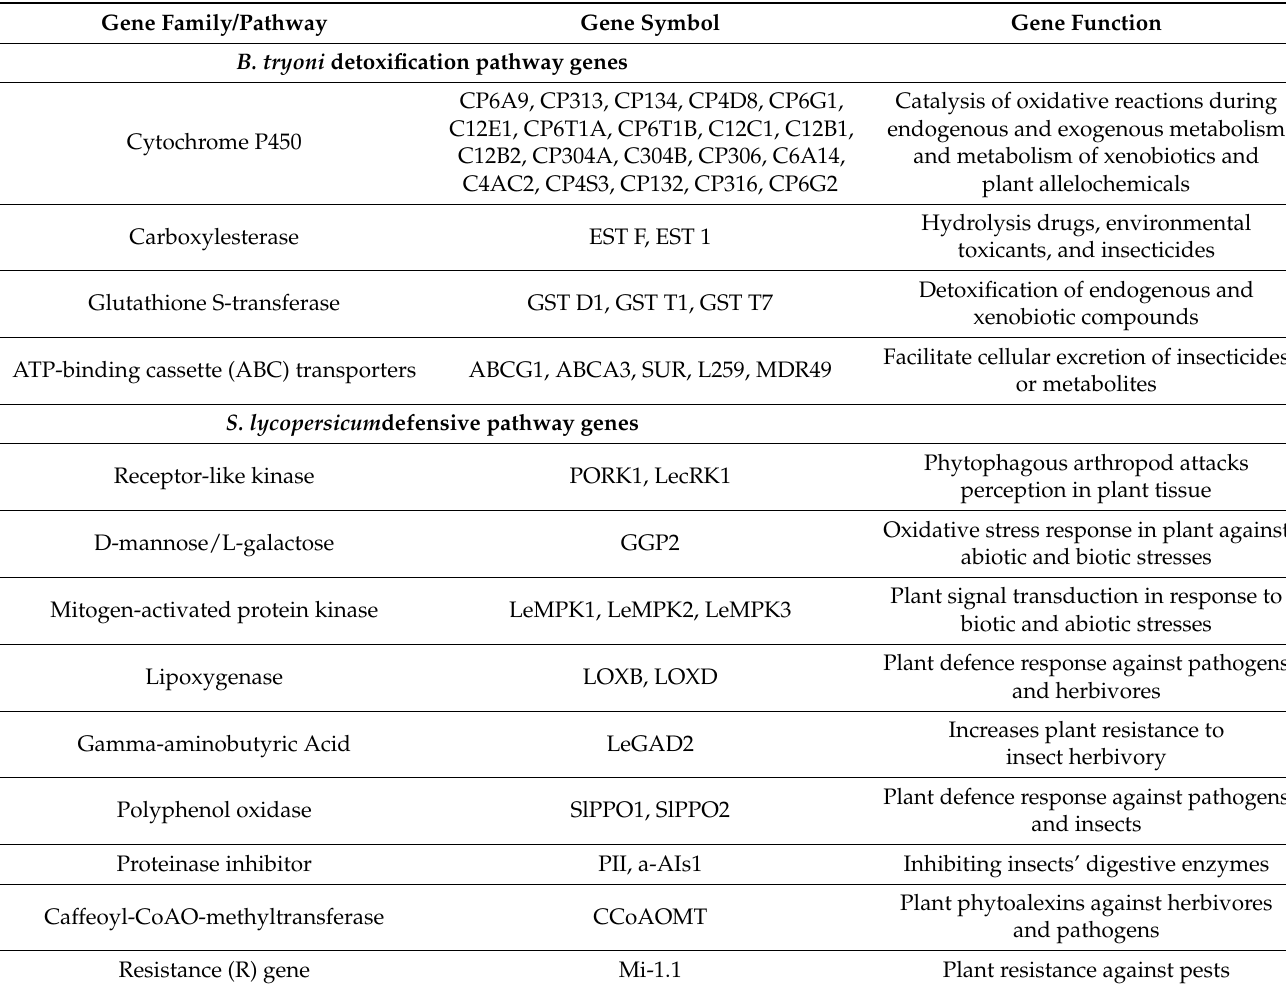
Table 1. Genes selected for studying plant-induced defence/insect-detoxification interactions that occur between Bactrocera tryoni larvae feeding in Solanum lycopersicum